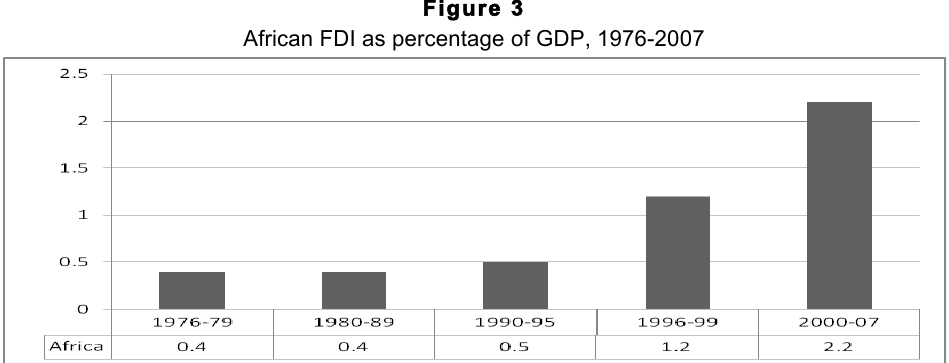
African FDI as percentage of GDP,